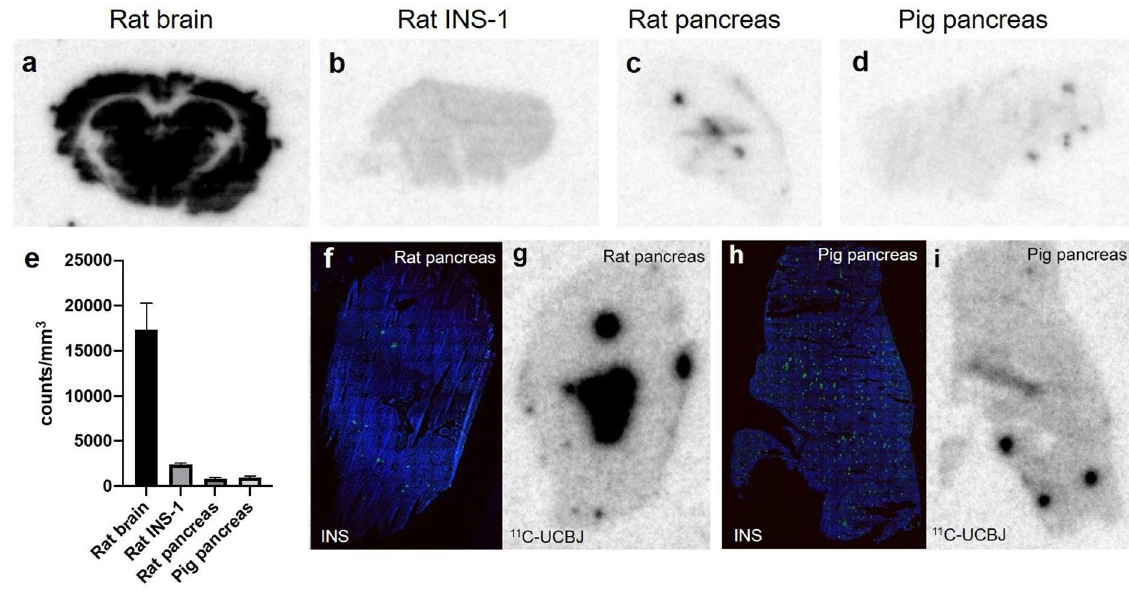
Figure 2. In vitro autoradiographic binding studies in the brain and pancreas. Representative autoradiograms of [ 11 C]UCB-J binding in sections of rat brain ( a ), rat insulinoma (INS-1) tumor ( b ), rat pancreas ( c ) and pig pancreas ( d ). The binding intensities were comparable, as all representative sections were from the same autoradiographic plate. Quantified binding was higher in the brain and INS-1 than in the rat pancreas ( e ). Rat ( g ) and pig ( i ) pancreases demonstrated visually discrete focal binding patterns that were suspected to represent islets, but correlative staining (blue color for DAPI, green color for insulin) for insulin ( f , h ) indicates poor overlap between [ 11 C]UCB-J binding and islets of Langerhans.